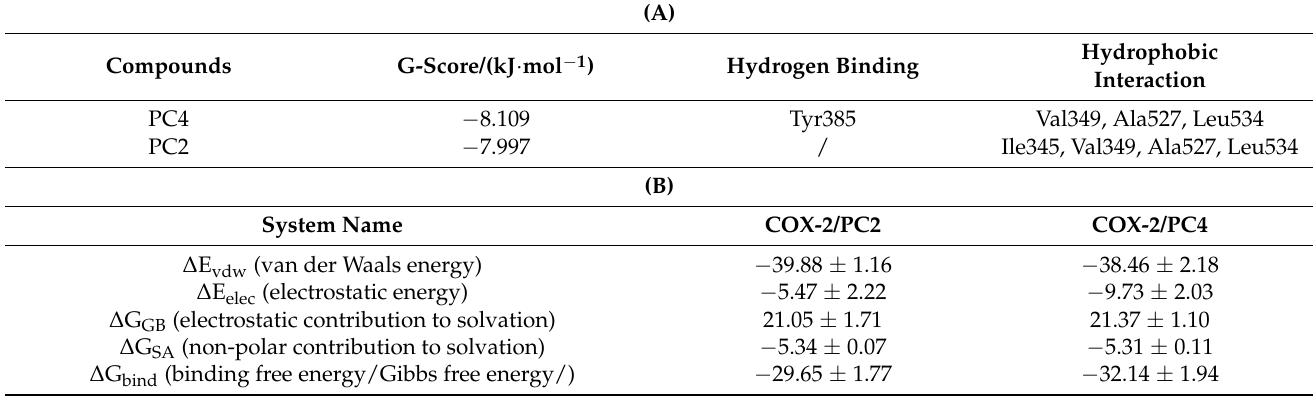
Table 1. ( A ) Docking scores and interaction analysis of hydroxy-2,4,7-trimethoxyphenanthrene (PC2), 6,7-dihydroxy-2,4- dimethoxy-phenanthrene (PC4) docking with cyclooxygenase-2 (COX- 2). ( B ) Binding energy of two compounds with COX-2 protein (Note. ∆ E vdw : van der Waals